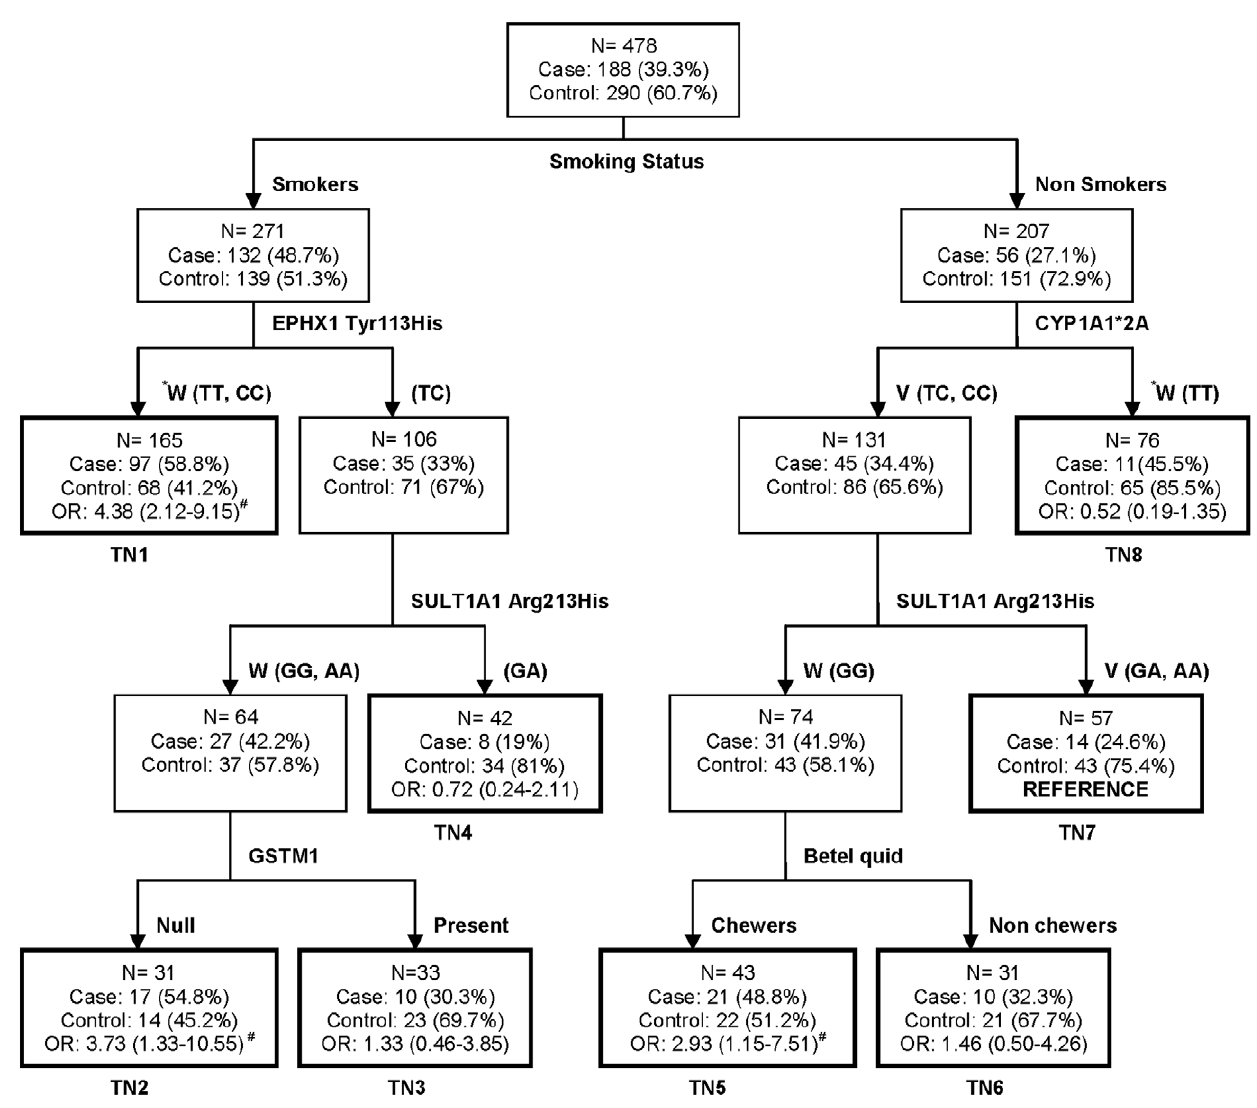
Figure 1. Classification and regression tree model for xenobiotic metabolizing gene polymorphisms and environmental risk factors. Terminal nodes are thick bordered. * W: Wild type genotype; V: Variant genotype, TN: Terminal Node, # p value , 0.05.